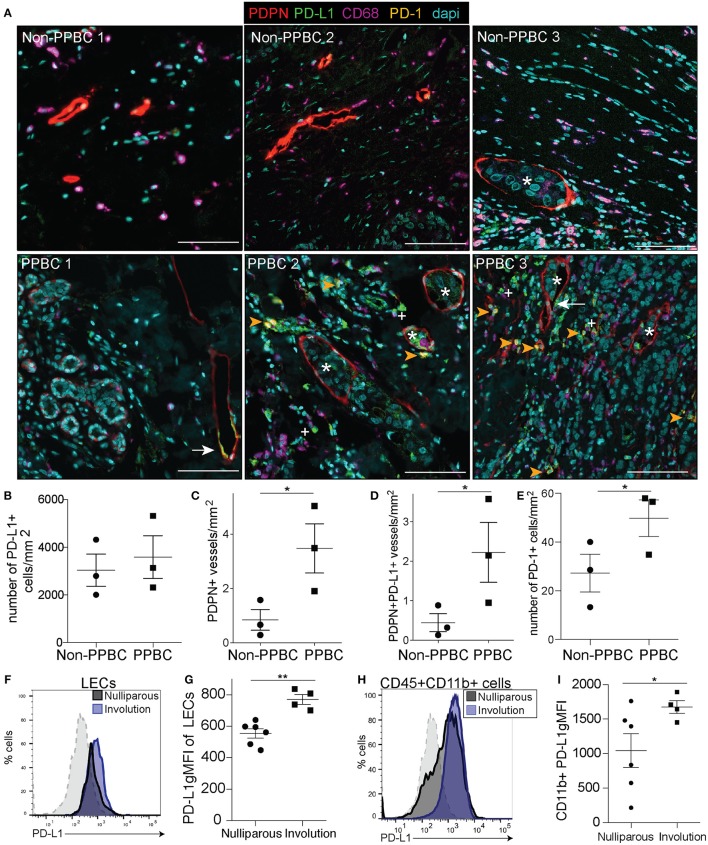
PDPN/PD-L1/PD-1 in post-partum patients and mouse mammary tumor models. (A) Tumor adjacent mammary tissues from three nulliparous non-post-partum breast cancer patients (Non-PPBBC) and three patients with post-partum breast cancer (PPBC) stained for PDPN (red), PD-L1 (green), CD68 (magenta), PD-1 (orange), and dapi (cyan). Asterisks indicate tumor cells found within the lymphatic vessel, white arrows indicate PD-L1+ lymphatic vessels, plus signs indicate PD-L1+ macrophages (CD68) and orange arrows indicate PD-1+ cells. (B) Number of PD-L1+ cells in the peritumoral region of the patients from A. (C) Number of PDPN+ vessels in the peritumoral region of the patients from A. (D) Number of PDPN+ vessels that are also PD-L1+ in the peritumoral region of the patients from A. (E) Number of PD-1+ cells in the peritumoral region of the patients from A. (F) Histogram of PD-L1 expression by LECs (CD45-EpCAM-CD31+PDPN+PD-L1+) from 66CL4 tumors implanted during mammary gland involution. Gray dotted line indicates a PD-L1 negative population (CD45+CD11b-F4/80-) that does not change. (G) gMFI of PD-L1 of LECs in tumor. (H) Histogram of PD-L1 expression by CD45+ CD11b+ cells from tumors implanted during mammary gland involution. Gray dotted line indicates a PD-L1 negative population (CD45+CD11b-F4/80-) that does not change. (I) gMFI calculated for PD-L1 from D. Data shown from animal experiments are from 1 representative experiment of 2 replicates with at least 4 tumors per group. Unpaired t-test: *p < 0.05; **p < 0.01. Scale bars are 100 microns in length.